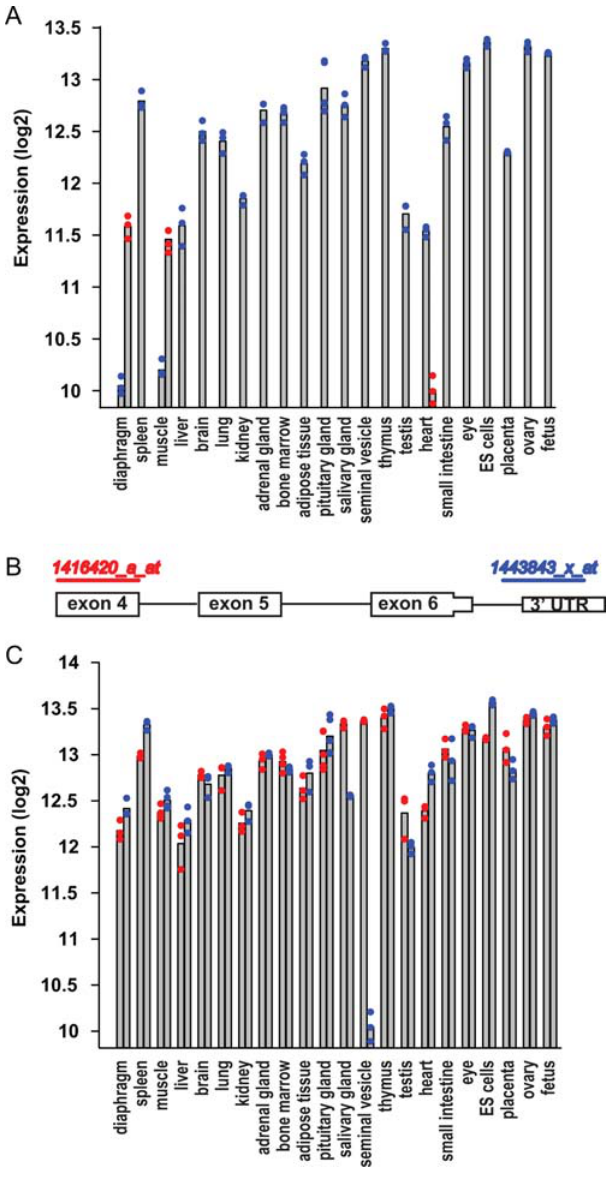
Figure 4. Two biological mechanisms underlying more pro- nounced variation in gene expression. ( A ) Expression of Rpl3 (blue) and Rpl3l (red) in 22 different tissues. Note that tissues where Rpl3l was expressed (heart, diaphragm and muscle) had the lowest expression of Rpl3 . ( B ) Schematic of Affymetrix probeset binding sites on the Rpl9 transcript. Probeset 1443843_x_at (blue) binds most 3 9 and probeset 1416420_a_at (red) binds more upstream. ( C ) Expression levels of Rpl9 as detected by each of the probesets shown above.